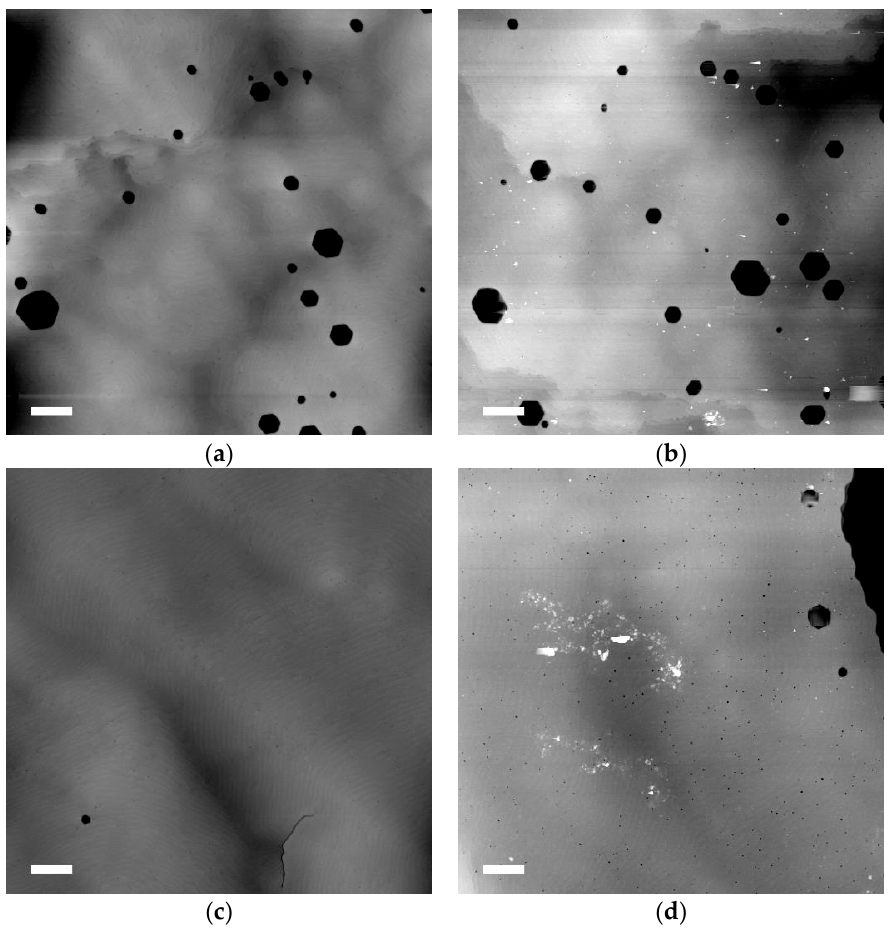
Figure 2. Atomic force microscope (AFM) images with a 5 µm scan size for: ( a ) sample A as grown; ( b ) sample A after ECE; ( c ) sample B as grown; and, ( d ) sample B after ECE. Lateral scale bars are 500 nm and the z range is 20 nm.